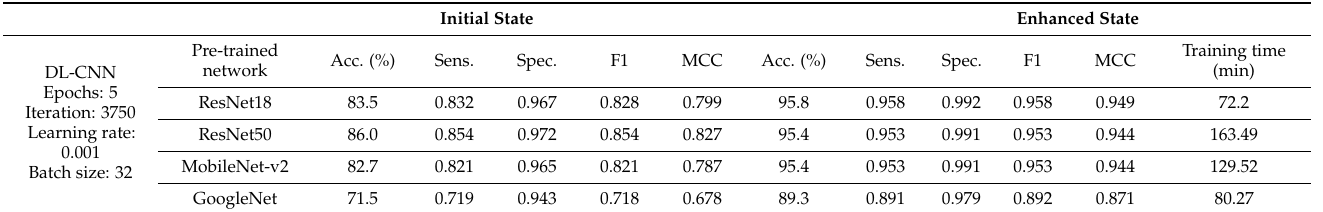
Table 7. HAR performance metrics in the WISDM dataset.